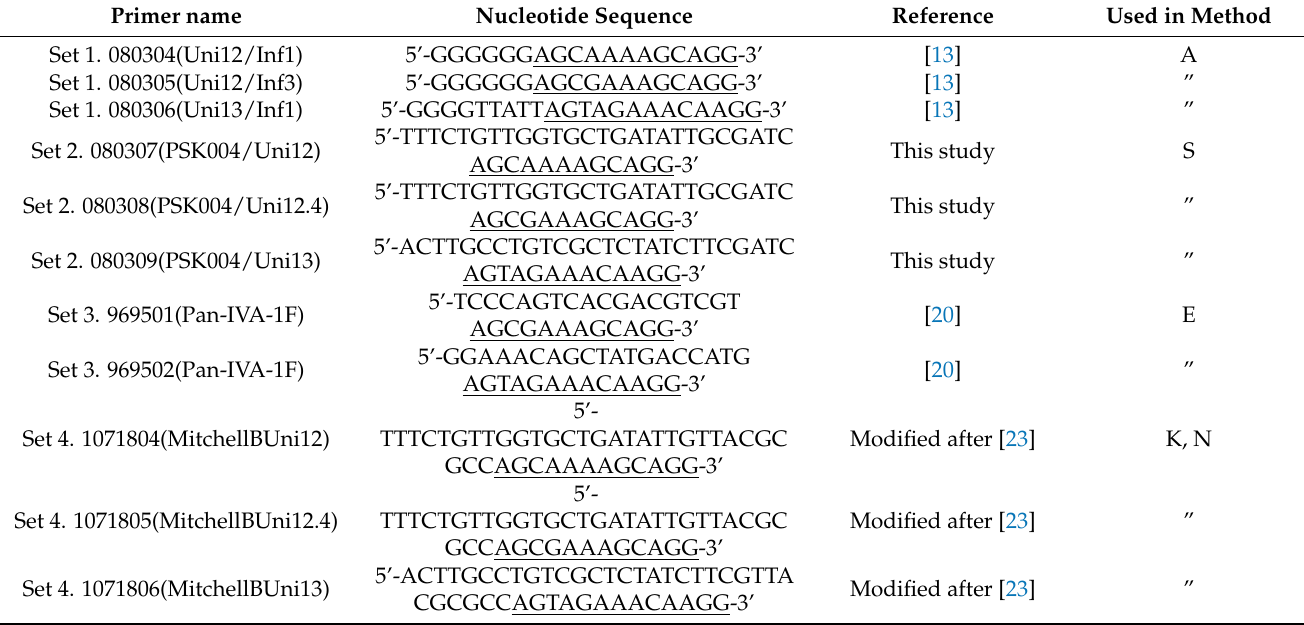
Table 2. Primer sets for avian influenza virus whole-genome amplification. Underlined sequences correspond to conserved sequences in influenza A